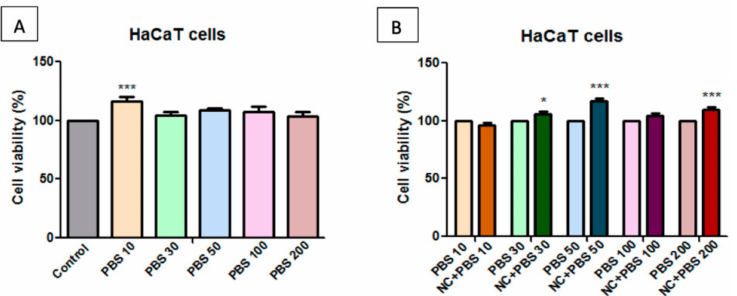
Figure 9. A —E ff ect of phosphate saline bu ff er (PBS) at di ff erent concentrations on human keratinocytes